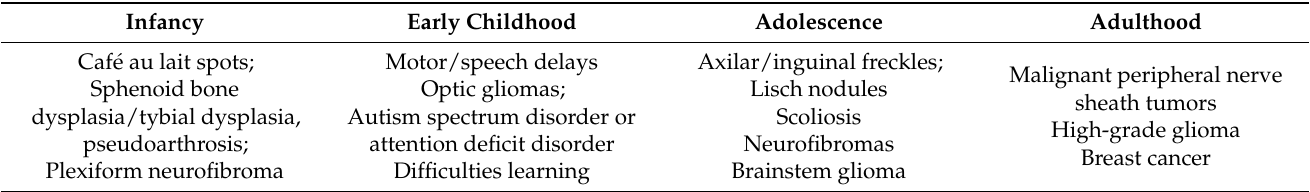
Table 1. Clinical manifestations for Neurofibromatosis type 1 (adapted after